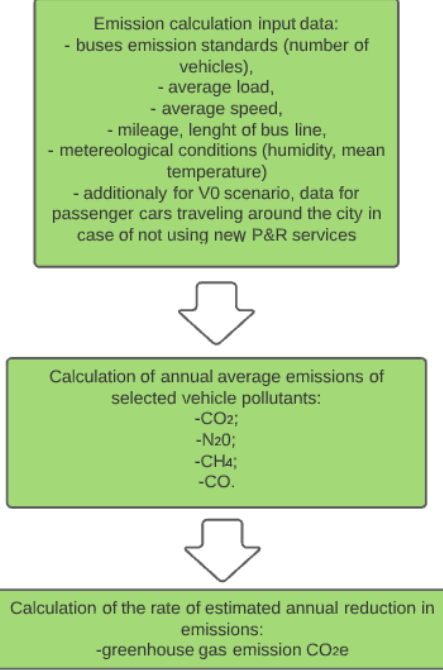
Figure 2. Diagram showing author’s logic for CO 2 e emission calculation methodology for buses.